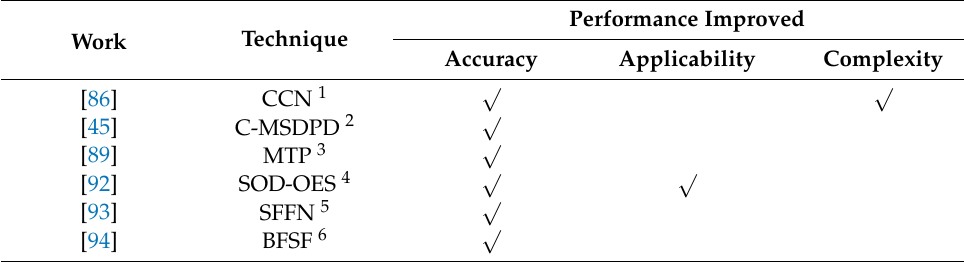
Table 11. Summary of steganalysis methods based on ACB. Work Technique